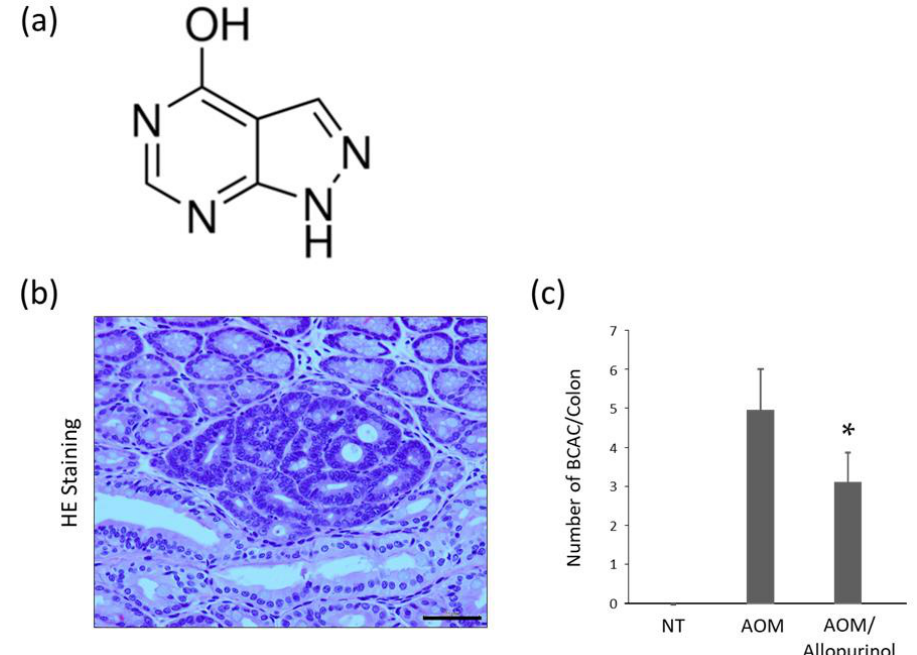
Figure 1. The chemical structure of allopurinol and AOM-induced colorectal pre-neoplastic lesions in the experimental mice. ( a ) The chemical structure of allopurinol. ( b ) A representative image of the β -catenin accumulated crypt (BCAC) stained with hematoxylin and eosin in the colon of the experimental mice. The epithelium has basophilic cytoplasm and hyper chromatic nuclei. Scale bar, 100 µm. ( c ) The number of BCACs per colon. Each column represents the mean ± SD. Asterisk (*) indicates statistically significant difference compared to the azoxymethane (AOM)-treated group; p < 0.05. NT, no treatment.